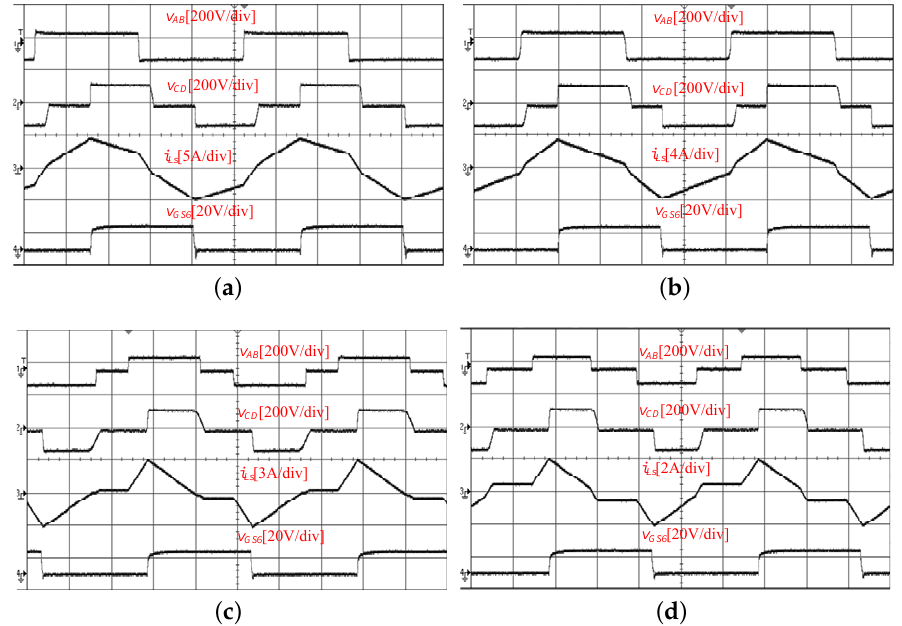
Figure 12. Experimental waveforms at four different power levels under the proposed route for V in = 80 V and V o = 120 V, time scale: (2 µ s/div), ( a ) 200 W; ( b ) 150 W; ( c ) 100 W; ( d ) 50